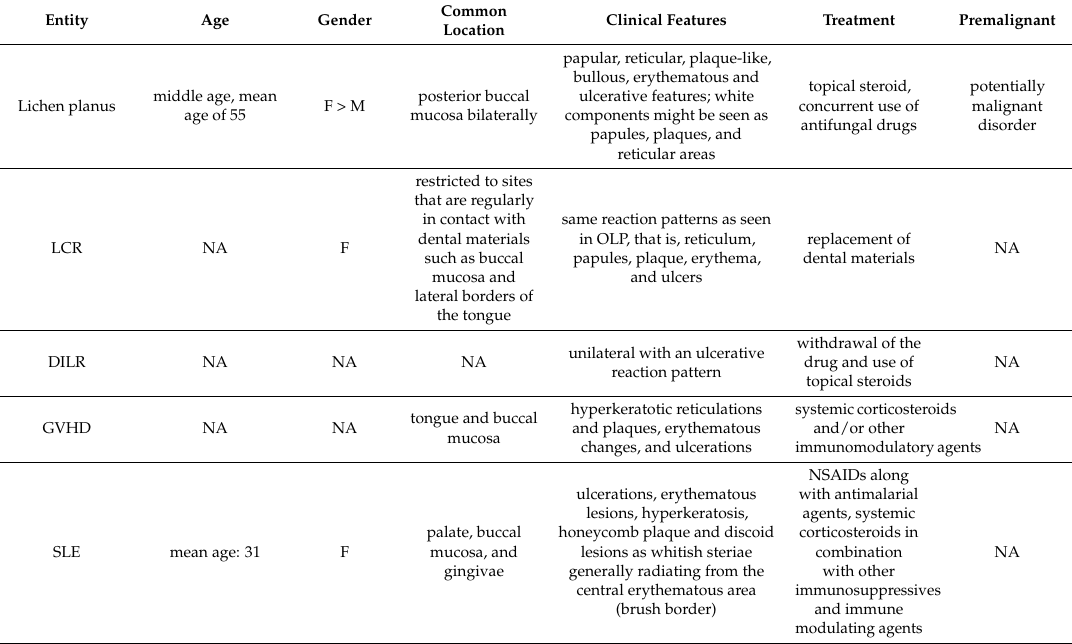
Table 3. Characteristics of acquired white lesions that cannot be scraped off, with specific pattern. Entity Age Gender Common Location Clinical Features Treatment Premalignant Lichen planus middle age, mean age of 55 F > M posterior buccal mucosa bilaterally LCR NA F DILR NA NA NA unilateral with an ulcerative reaction pattern GVHD NA NA tongue and buccal mucosa SLE mean age: 31 F